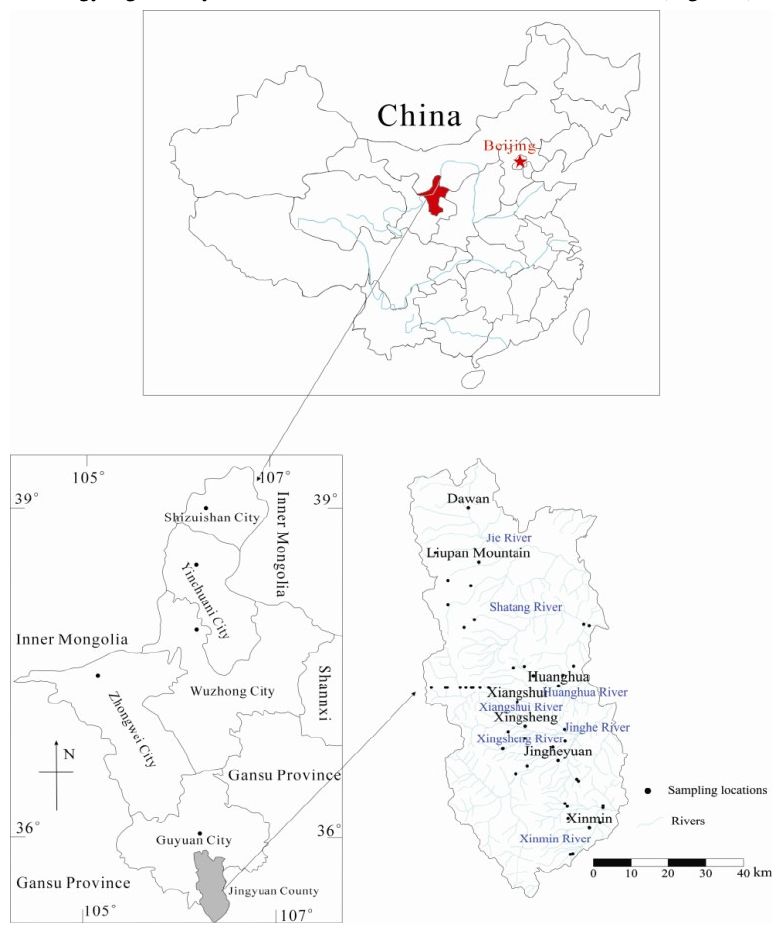
Figure 1. Location of study